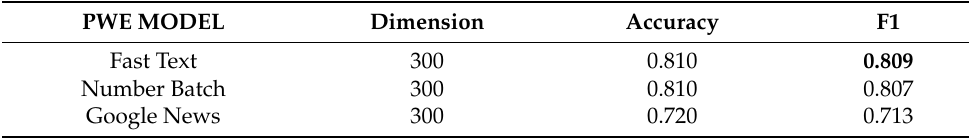
Table 12. Comparison of the PWE